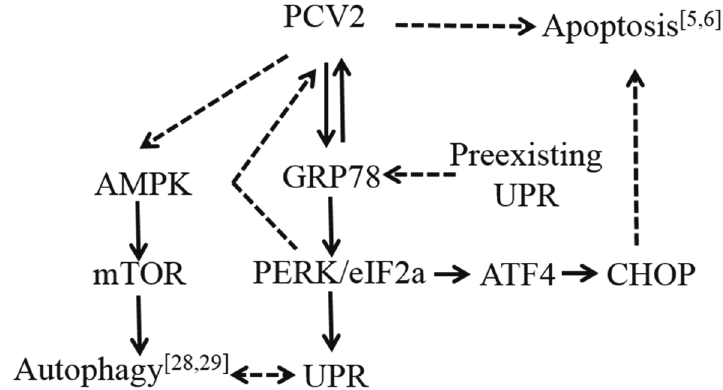
Figure 8. A schematic model of cellular responses during porcine circovirus type 2 infection. Arrows with solid lines indicate induction, while those with dashed lines suggest that the molecules or pathways remain to be investigated.